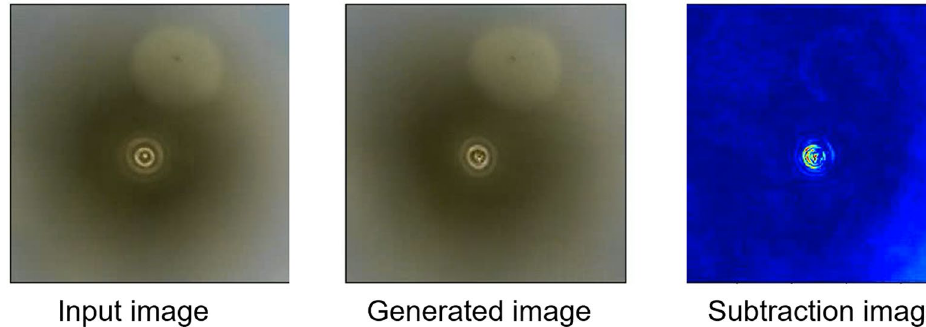
Fig. 11 Experimental results of normal new cast iron pipe